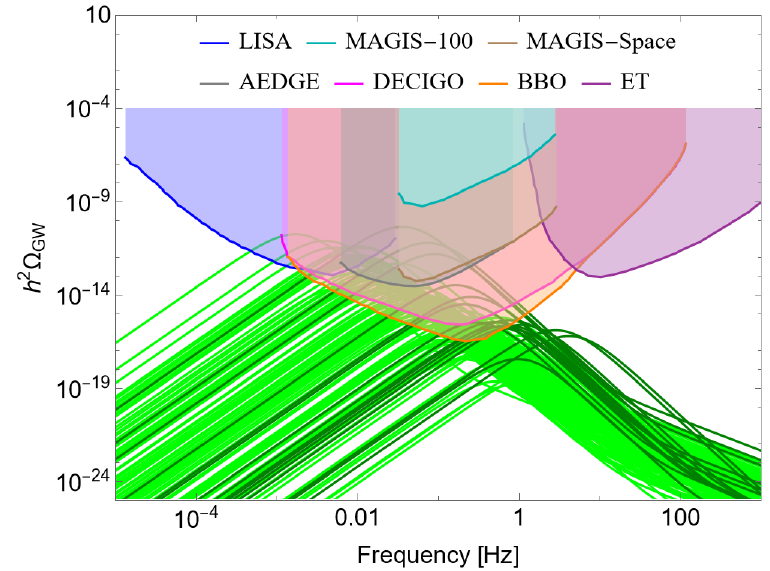
Figure 11. Gravitational wave signals of the SFOEWPT from benchmark points generating the observed baryon asymmetry, the dark matter relic abundance, and satisfying all phenomenological constraints with m 2 (dark green curves) and m 2 (light green curves). The power- a < m h / a > m h / law integrated sensitivity curves for LISA, MAGIS-100, MAGIS-Space, AEDGE, DECIGO, BBO, and ET are shown for